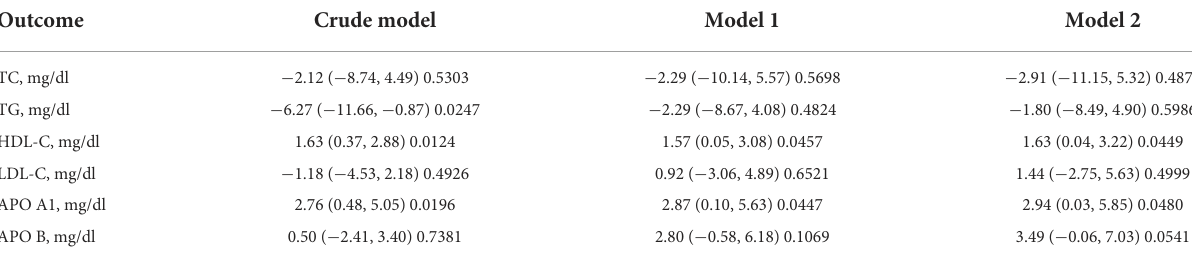
TABLE 4 Multivariable linear regression about serum zinc and lipid